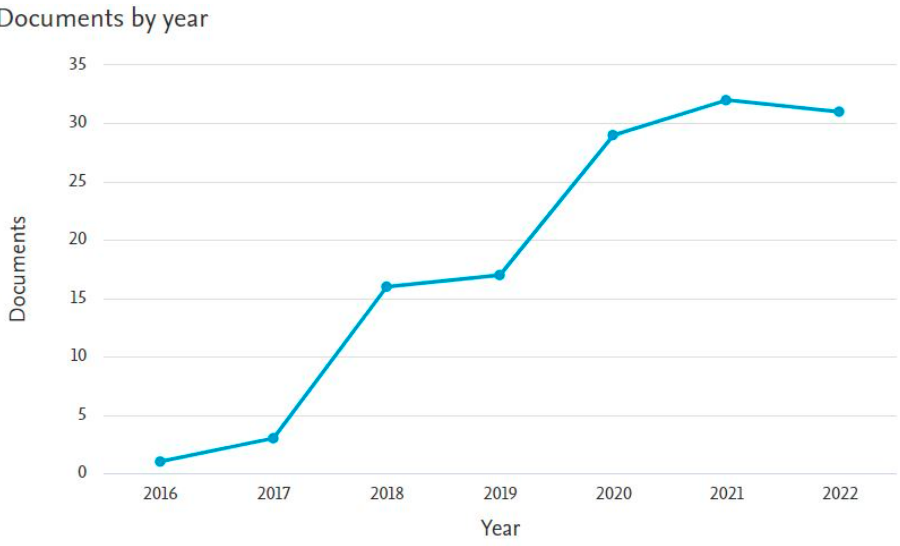
Figure 1. Publishing trend of the sample. Keywords: blockchain, IoT, smart grids and energy.